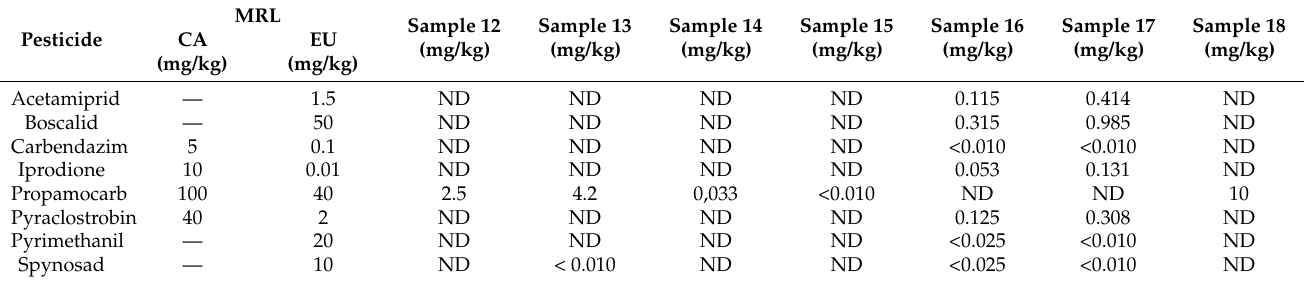
Table 2. Maximum residue limits (MRL) for Codex Alimentarius (CA) and European Union (EU), results of positive